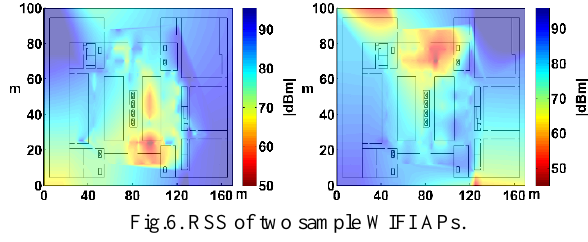
Fig.6. RSS of two sample WIFI